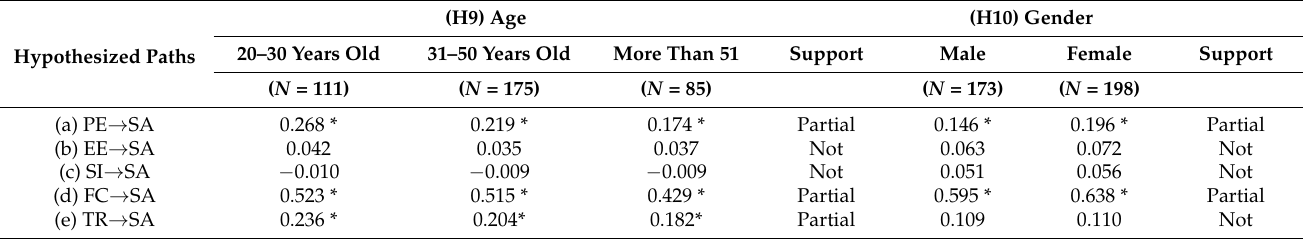
Table 7. Moderating effect of age and